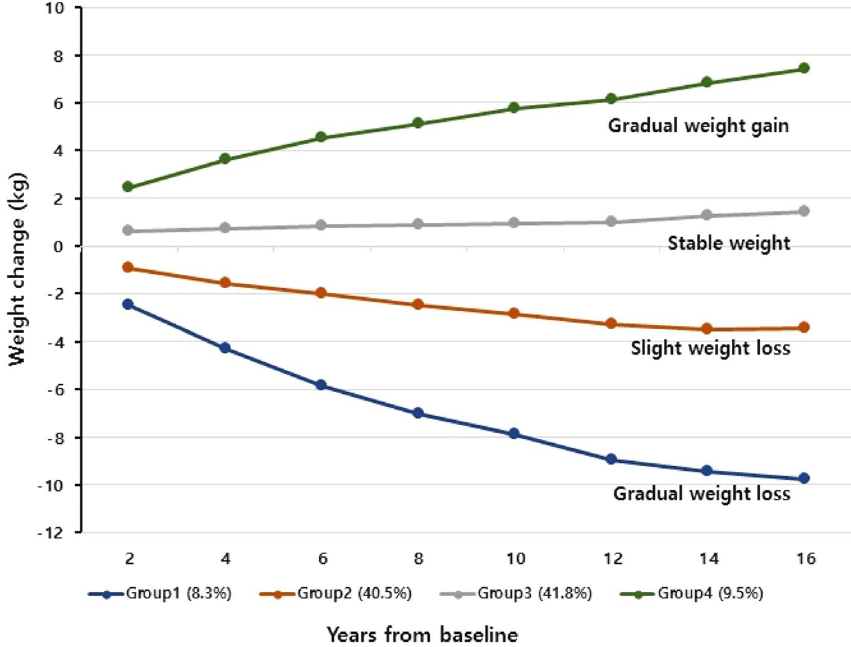
Figure 1. Weight changes by trajectory group derived from group-based modeling over the 16-year study duration. The solid line indicates the estimated average